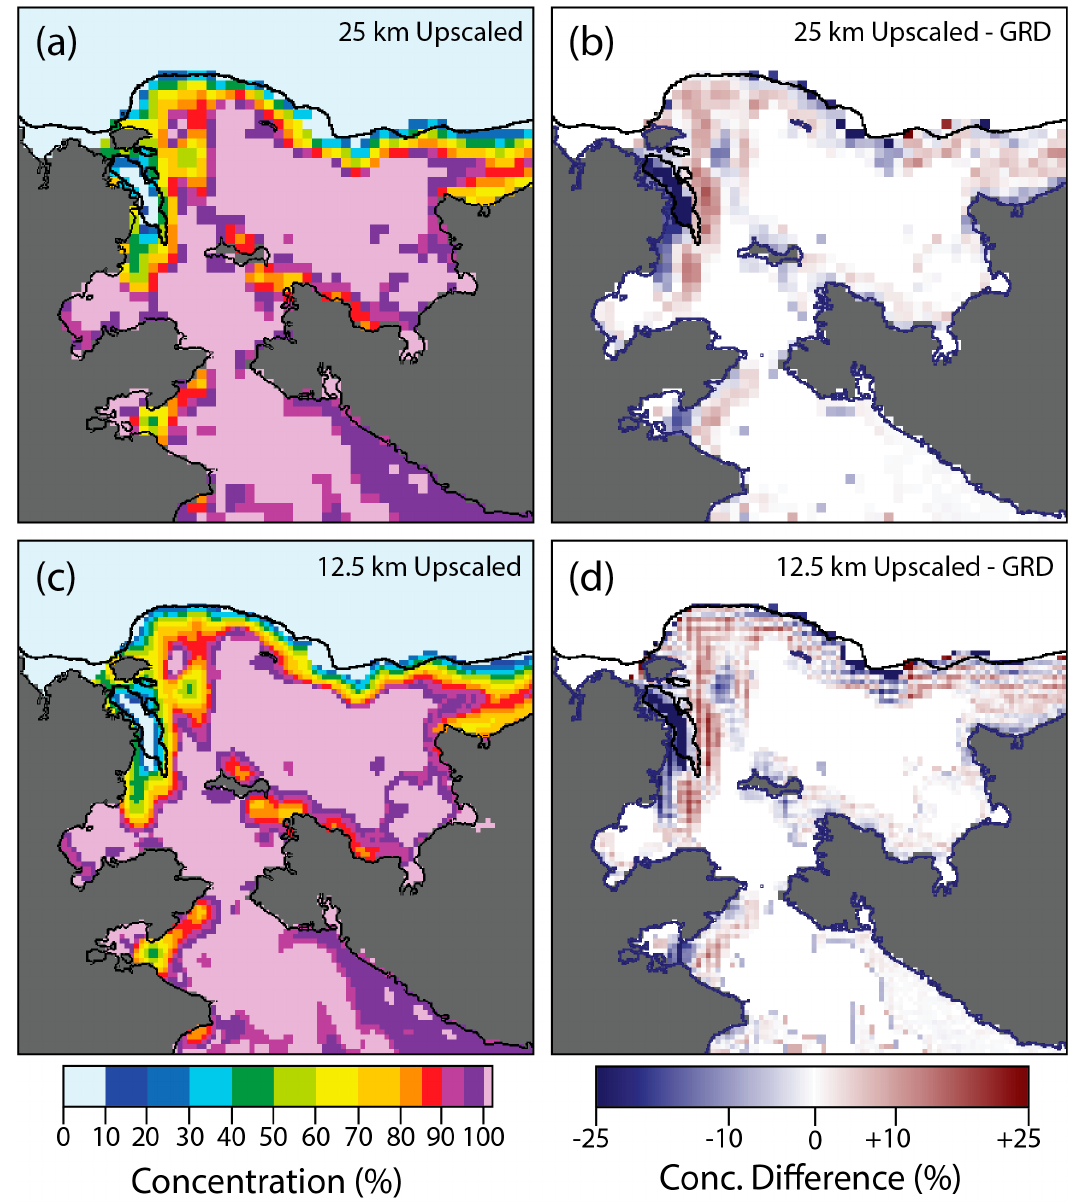
Figure 6. Bering Sea 1 March 2014 (a) 25 km upscaled rSIR sea ice concentration, (b) 25 km upscaled rSIR minus 25 km GRD concentration difference, (c) 12.5 km upscaled rSIR concentration, and (d) 12.5 km upscaled rSIR minus 25 km GRD concentration difference.